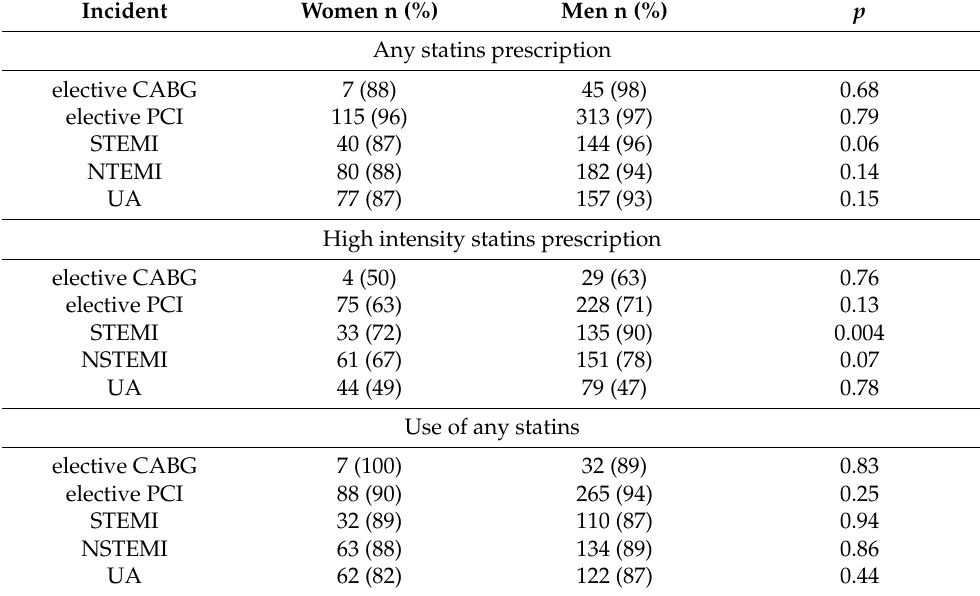
Table 7. Statins prescription and the use of statins in men and women depending on the type of qualifying